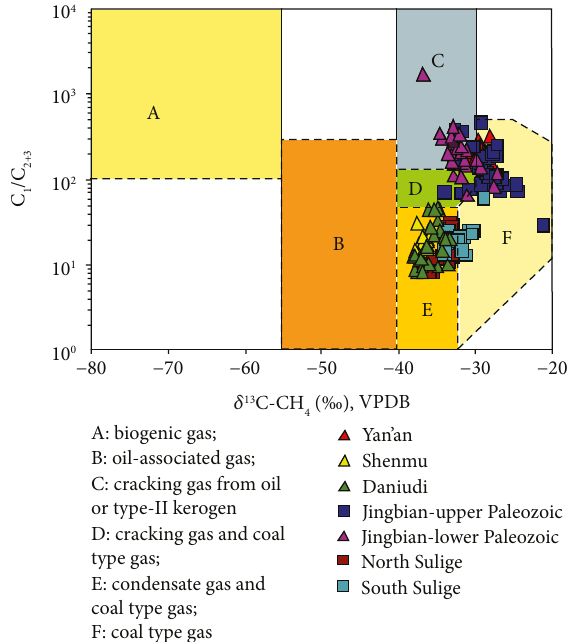
Figure 7: Plot of C after [38 –